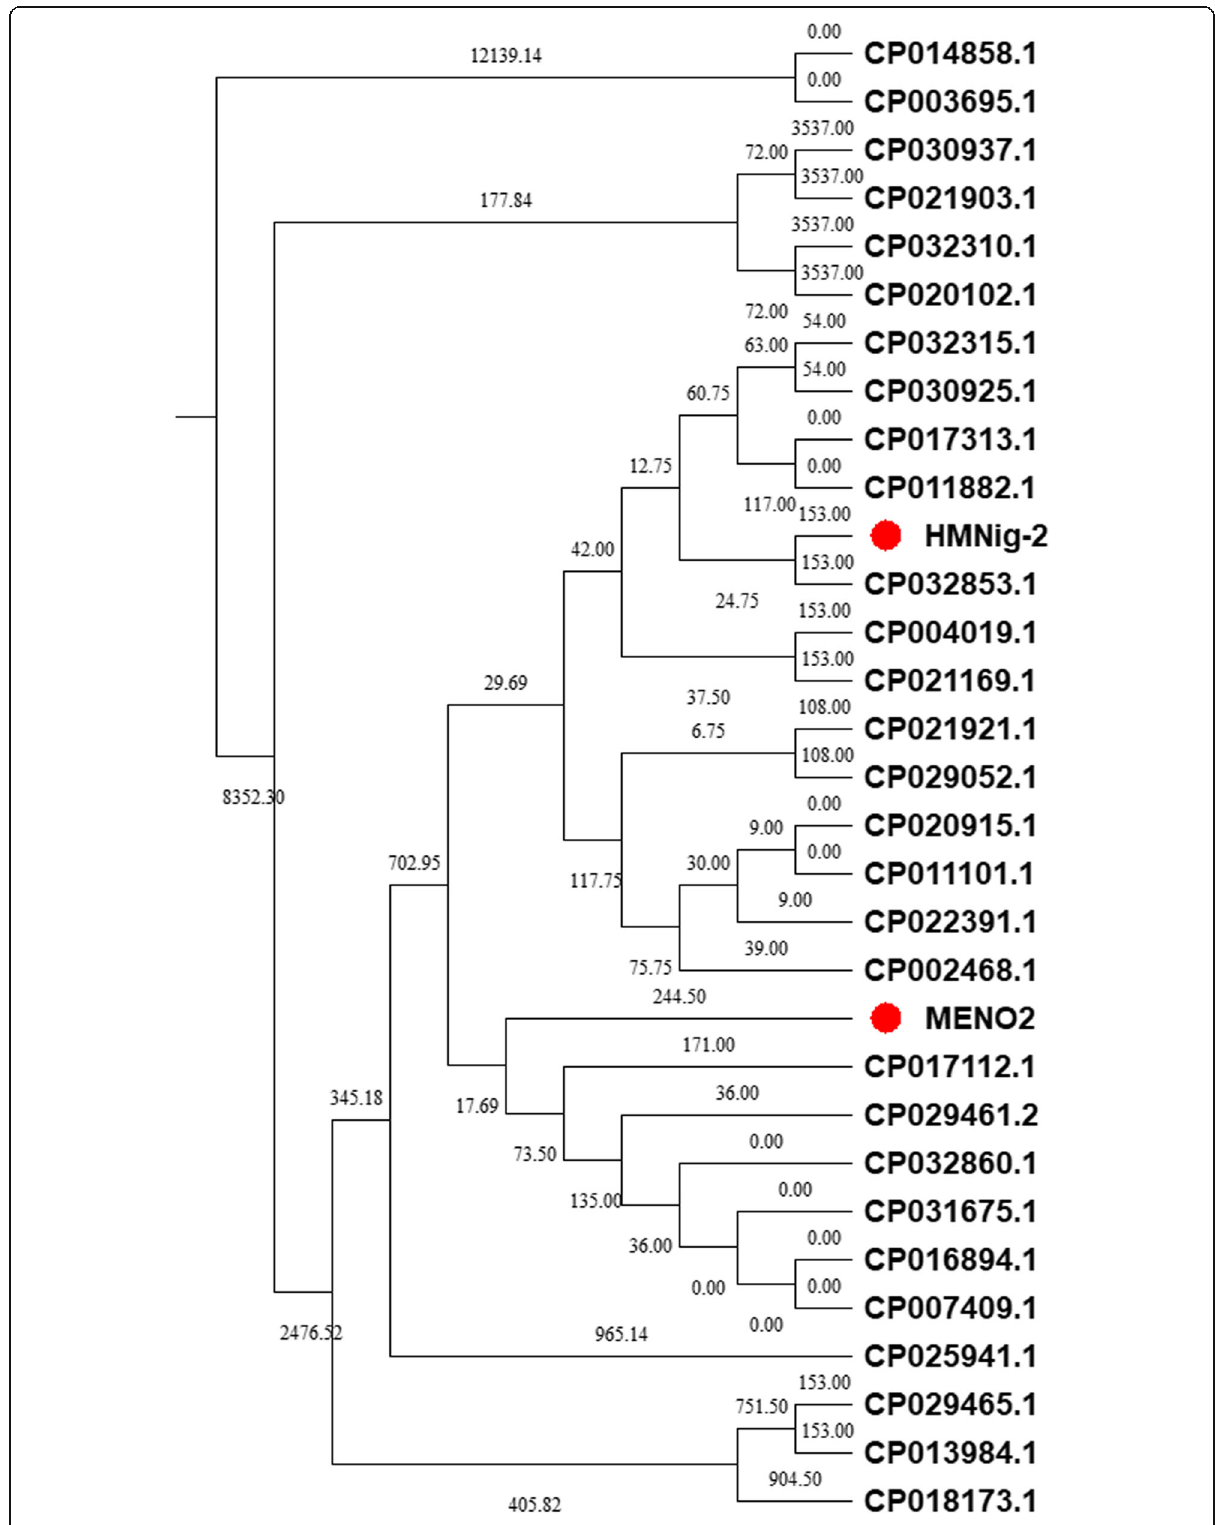
Fig. 1 Neighbor-joining phylogenetic tree of the B. subtilis HMNig-2 and MENO2 genome, their closest neighbors from other B. subtilis strains are shown. Accession numbers are given in parentheses. Phylogenetic analysis was performed using